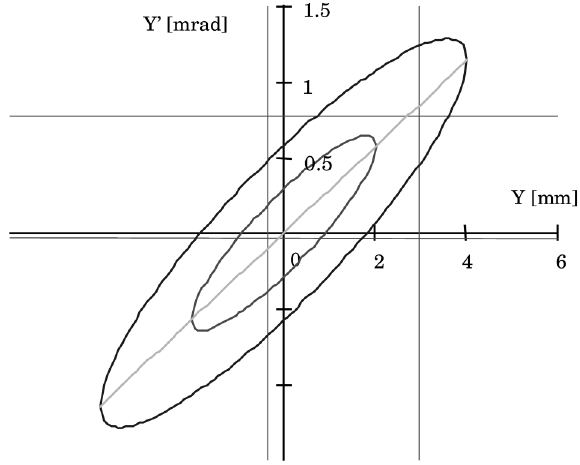
FIG. 9. Contour plot of x 2 values for the divergence and average angle of the whole beam and the core. FIG. 10. Estimated phase-space